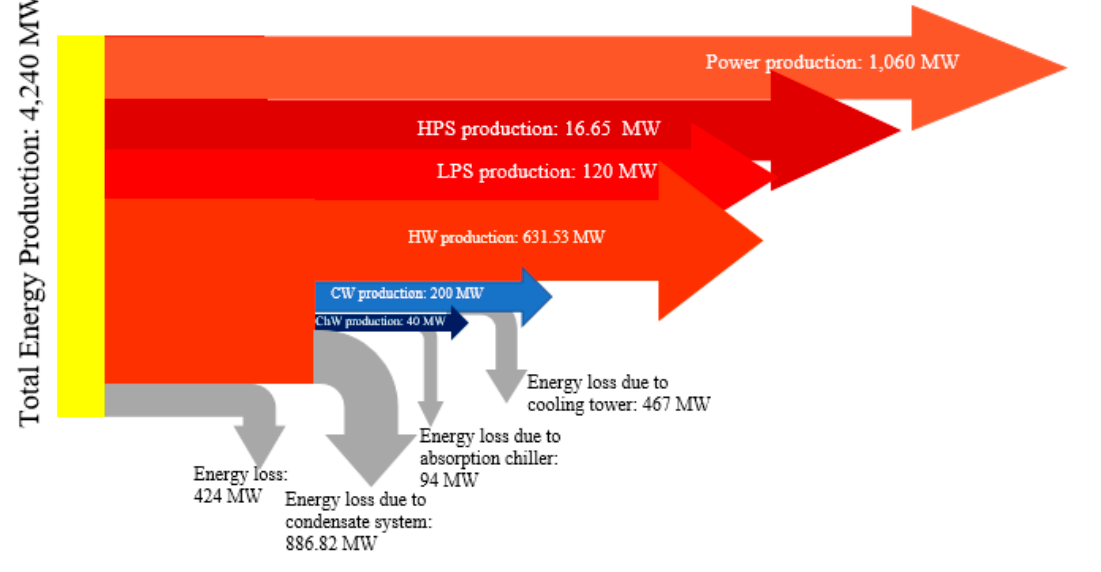
Figure 5. Energy balance for a trigeneration system at maximum turndown ratio. Table2. StreamdataforIndustrialPlantAwith ∆ T min, pp = 20 ◦ C(modifiedfromJamaluddin et al. [27]). Stream